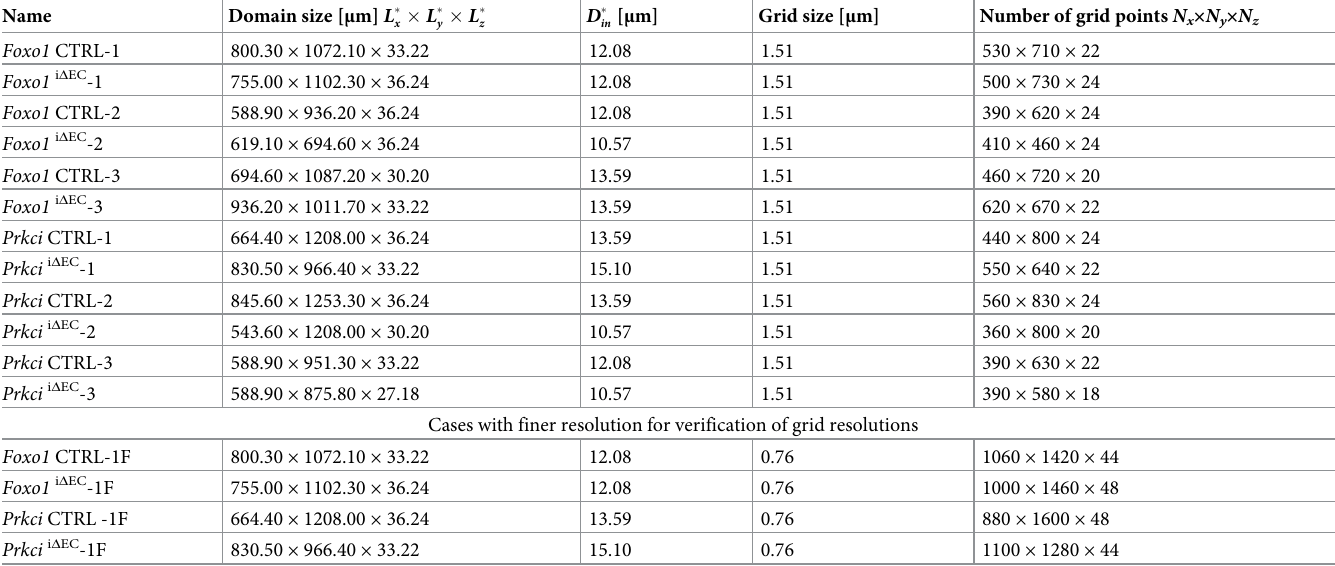
Table 1. Domain size and grid resolution for every model structure.